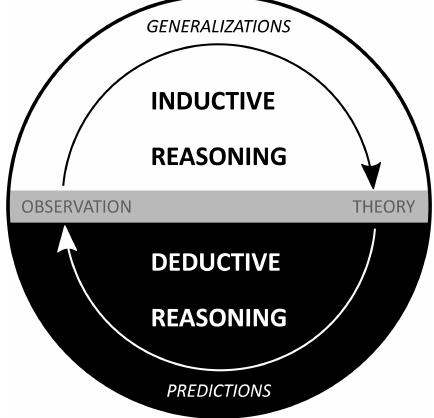
Figure 30. The hermeneutic circle (based on Miall,